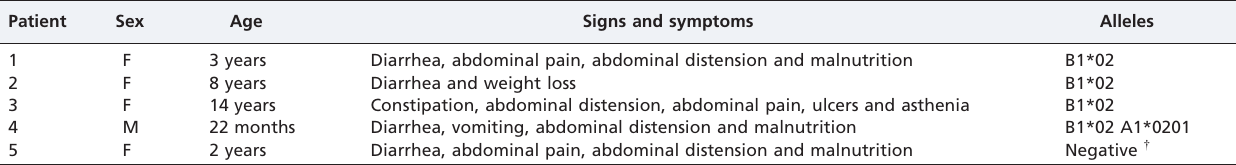
Table 3 - Characteristics of the patients without HLA DQ2 or DQ8, with regard to sex, age, diagnostic symptoms and alleles present in